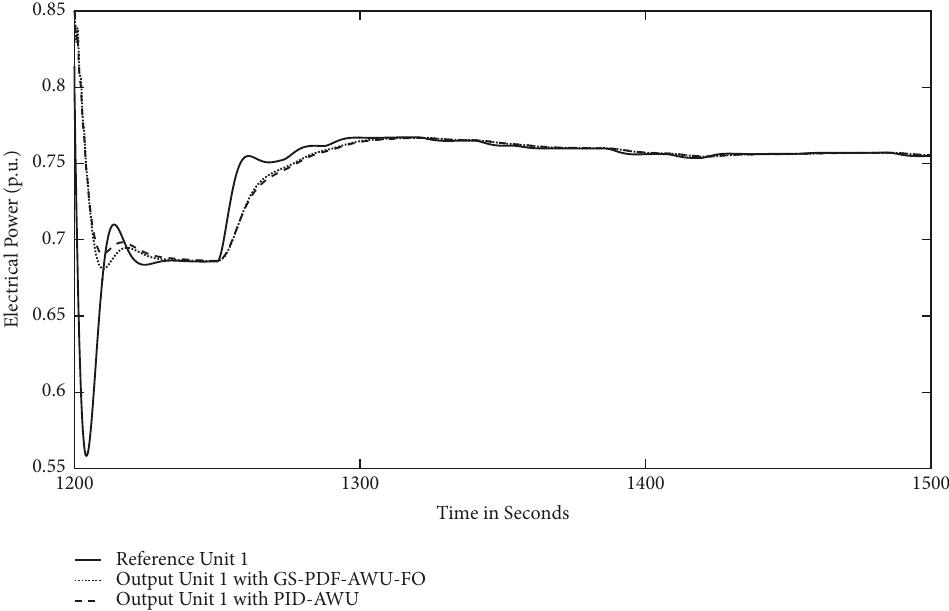
Figure 17: Evaluation of the responses produced by PID and GS-PDF-FO (both with antiwindup) with unit 1 in frequency variation (connected to the grid) and units 2-6 with 0.85 p.u. of fix operational point, h=0.9 p.u.